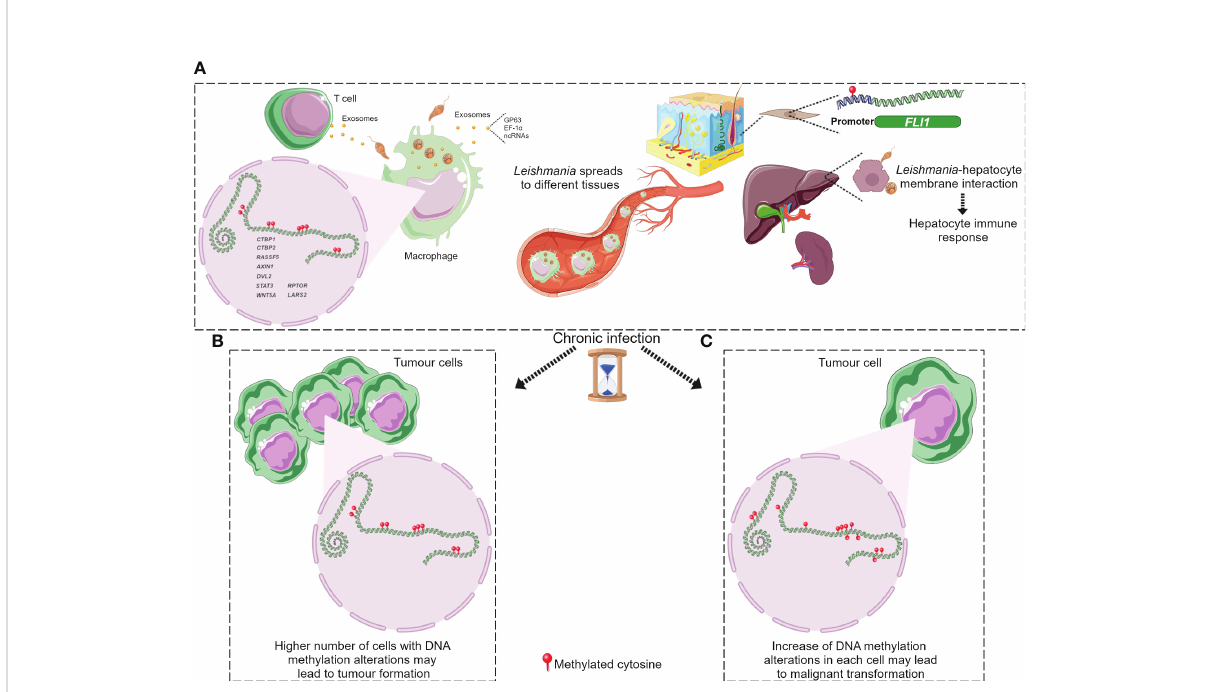
FIGURE 3 DNA methylation alterations upon Leishmania infection possibly leading to tumorigenesis. (A) Leishmania molecules, possibly delivered by exosomes, induce DNA methylation changes in macrophages and maybe in T cells. Parasite dissemination to different tissues may induce methylome alterations in other cell types, such as fi broblasts and hepatocytes, through Leishmania /host cell interaction. Cancer development may arise through different ways during chronic leishmaniasis: (B) increased number of cells with DNA methylation alterations; (C) additional methylome alterations in target cells. Figure created using Servier Medical Art images, licensed under a Creative Commons Attribution 3.0 Unported License;